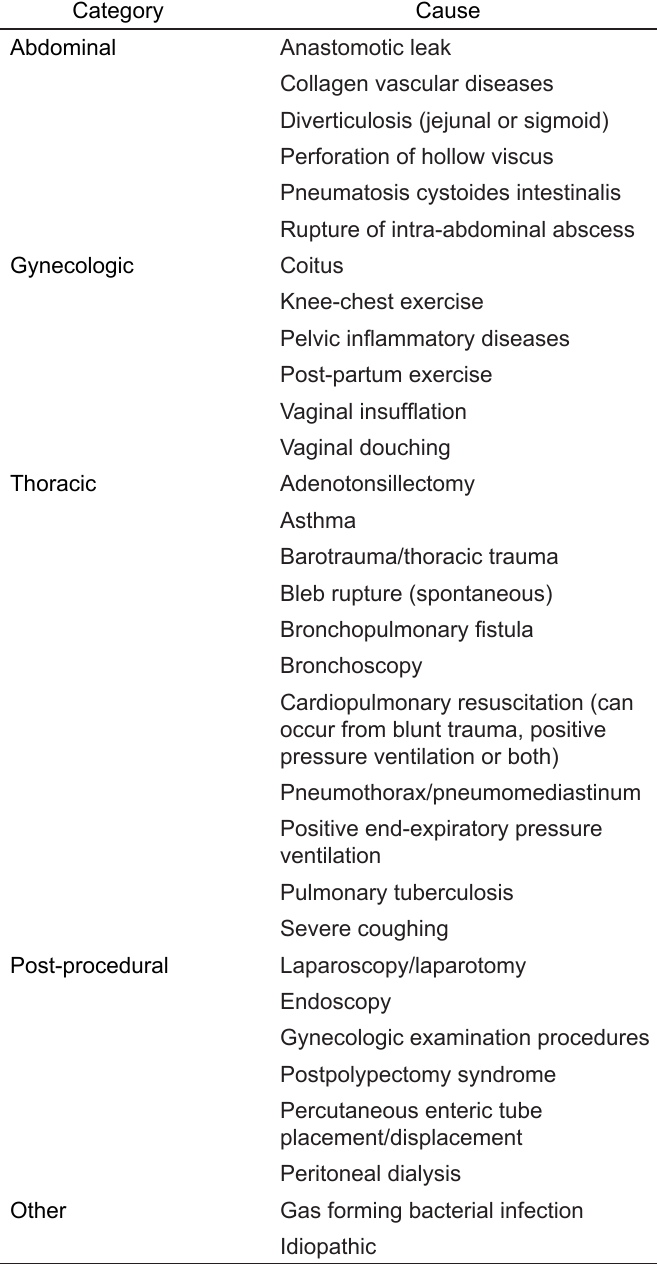
Table. Causes of